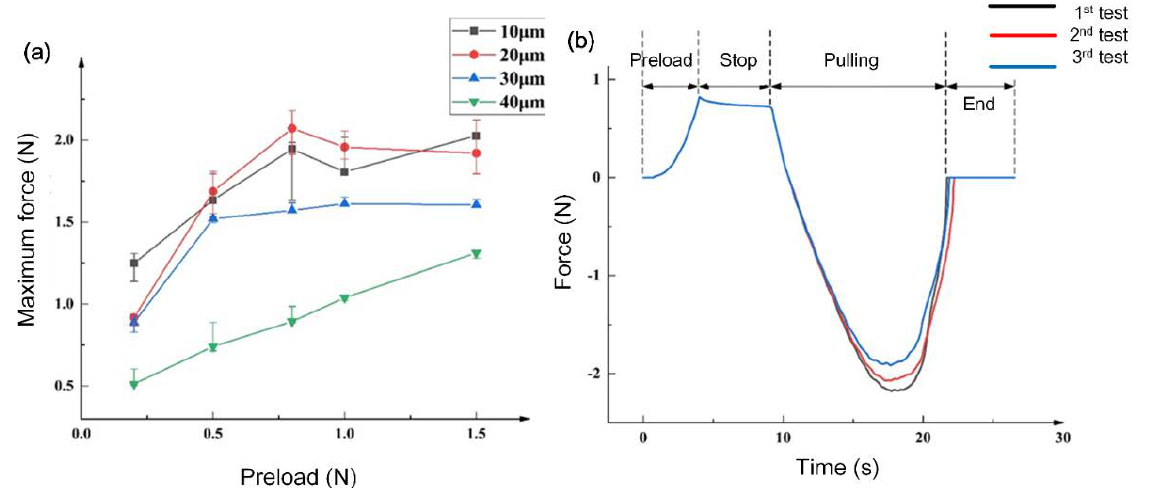
Figure 5. Dry adhesion test of the gecko-inspired dry adhesive surfaces. ( a ) Relationship curves between the maximum adhesive forces and the preload in comparing mushroom-like structures of 10, 20, 30 and 40 µ m diameter. ( b ) Dry adhesive test of gecko-inspired structures with diameter of 20 µ m, indicating the whole testing procedure, including preload and pulling process.